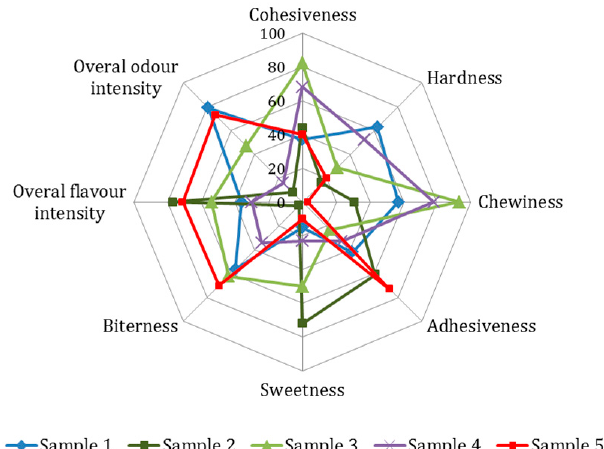
Figure 4. Sensory profile of protein bars. Sample 1–4: commercially available bars (Sample 1: protein 25.0 g; Sample 2: protein 5.2 g; Sample 3: protein 32.0 g; Sample 4: protein 14.2 g), Sample 5: created high-protein bar: protein 34.0 g.